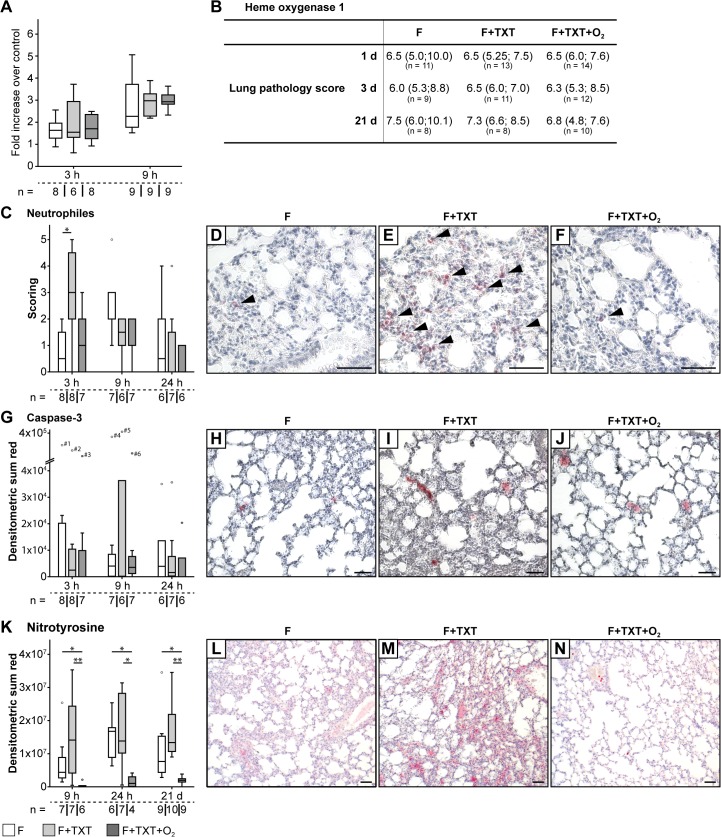
Microscopic and molecular analyses of lungs.(A) Lung tissue expression of HO-1 3 and 9 hours post-injury. (B) Quantitative analysis of lung histology after 1, 3 and 21 d. (C) Histological scoring of neutrophil stainings in the lungs and (D-F) representative slides 3 hours after injury showing increased numbers of neutrophils after TXT; arrows highlight positively stained neutrophils. (G) Analysis of caspase-3 staining and (H-J) representative slides of each group, 3 hours after injury. Values of outliers: #1 = 7.7x104; #2 = 6.69x104; #3 = 5.7x104; #4 = 2.96x105; #5 = 4.07x105; #6 = 6.16x104. (K-N) Positive nitrotyrosine staining was detected up to 21 days after surgery. O2 treatment significantly decreased the level of nitrotyrosine. Scale bars: 50 μm; box-plots represent medians and quartiles, whiskers represent the minimum and maximum values. Data represent medians and quartiles. Specimen numbers for each group are depicted. *p<0.05, **p < 0.001.